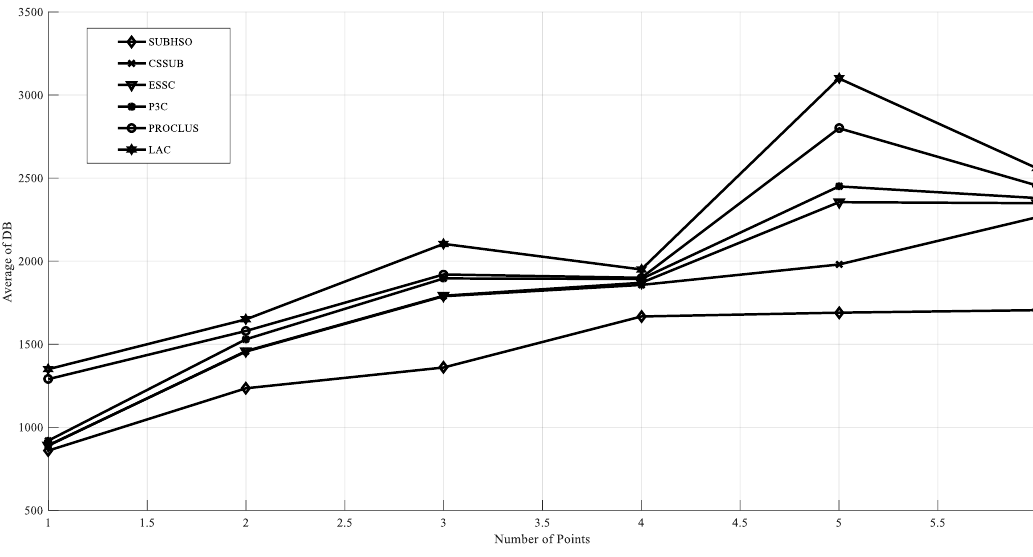
Fig. 11. Comparison of mean fitness function for different number of